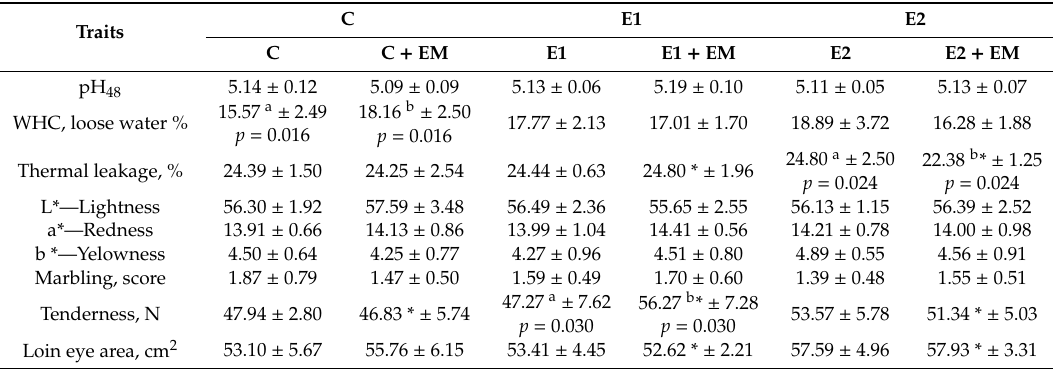
Table 3. E ff ects of e ff ective microorganisms (EM) on meat quality in pigs fed on diets with proteins of di ff erent